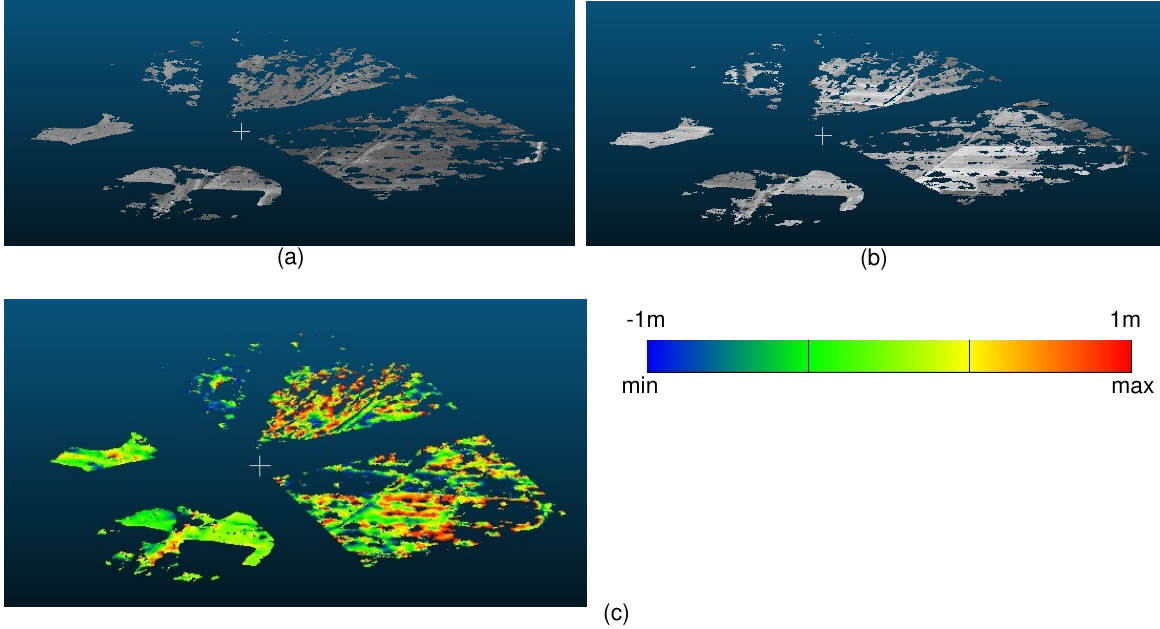
Figure 6. The output of the local 3D patch-based alignment procedure obtained for the dataset Fabas. (a) reference 3D point cloud, (b) historical 3D point cloud, (c) DoD (Difference of DEMs): elevation residual differences.